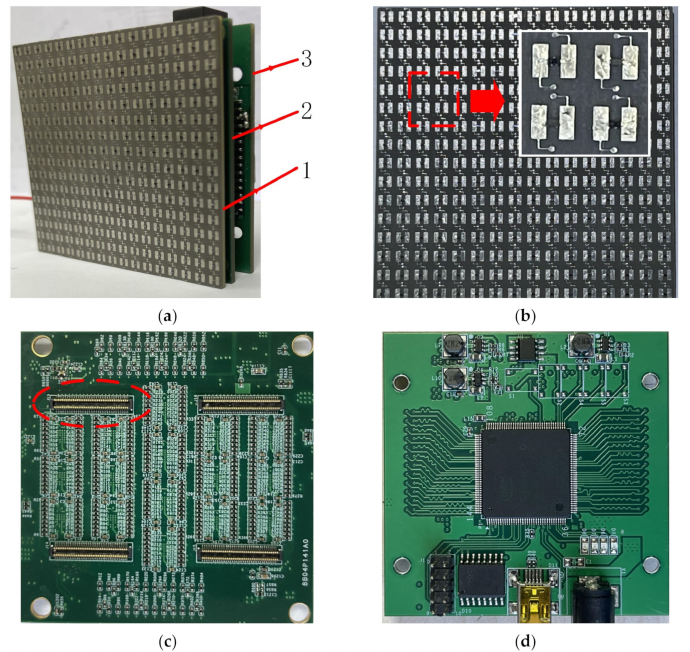
Figure 4. MSRRA prototype. ( a ) Laminated structure of the MSRRA prototype, from top to bottom; 1 is the MSRRA reflect aperture; 2 is the bias voltage generator; 3 is the beam-forming controller. ( b ) MSRRA aperture. ( c ) Bias voltage generator; the BTB connector is marked with a red circle; ( d ) Beam-forming